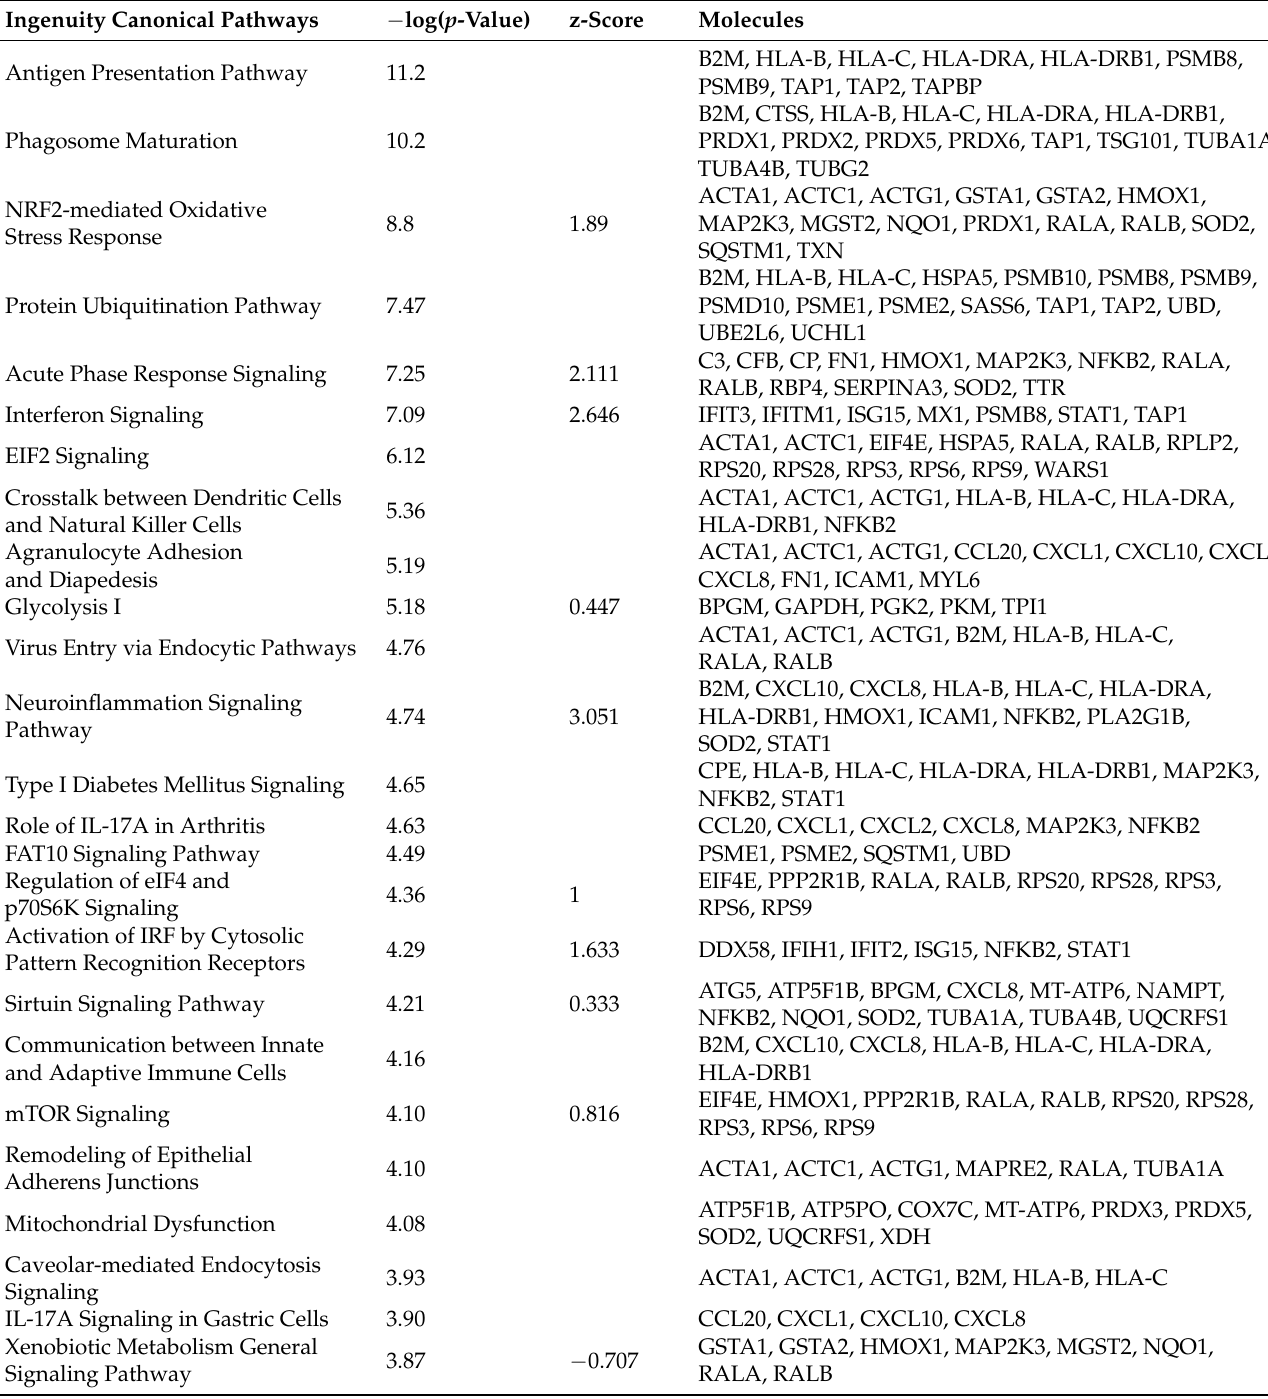
Table 2. Top 25 canonical pathways derived from the IPA